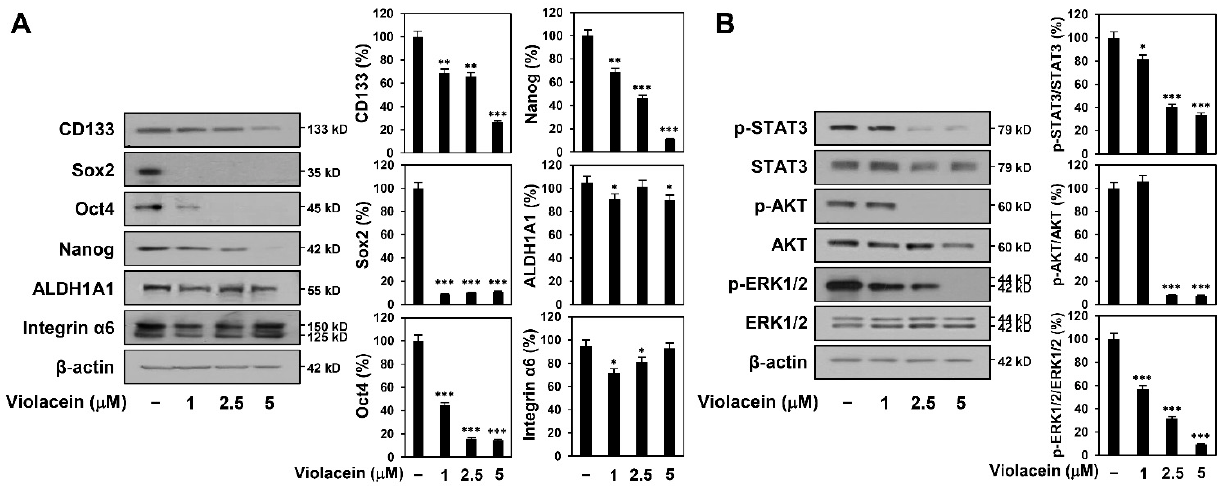
Figure 6. Violacein downregulates cancer stemness-related markers and STAT3/AKT/ERK signaling in Huh7 cancer stem- like cells. ( A,B ) The cells were treated with violacein (1, 2.5, and 5 µM) and were incubated with the CSC culture media for 72 h. Protein levels were detected by Western blot analysis using specific antibodies and were further quantified by densitometry. β -actin levels were used as an internal control. ∗ p < 0.05, ∗∗ p < 0.01, ∗∗∗ p < 0.001 vs. the control.